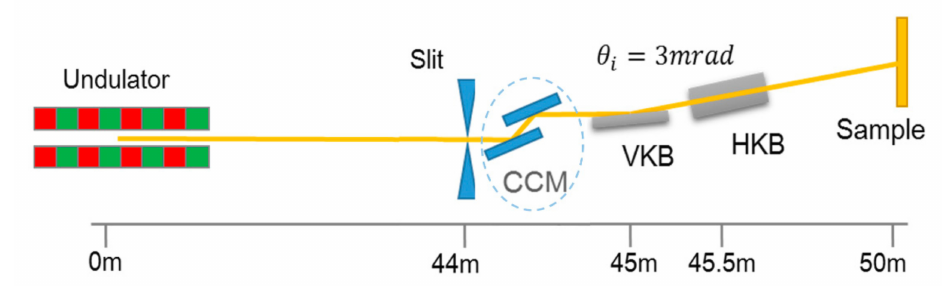
Figure 5. The layout of the beamline: VKB (vertical Kirkpatrick-Baez (KB) mirror) and HKB (horizontal KB mirror).